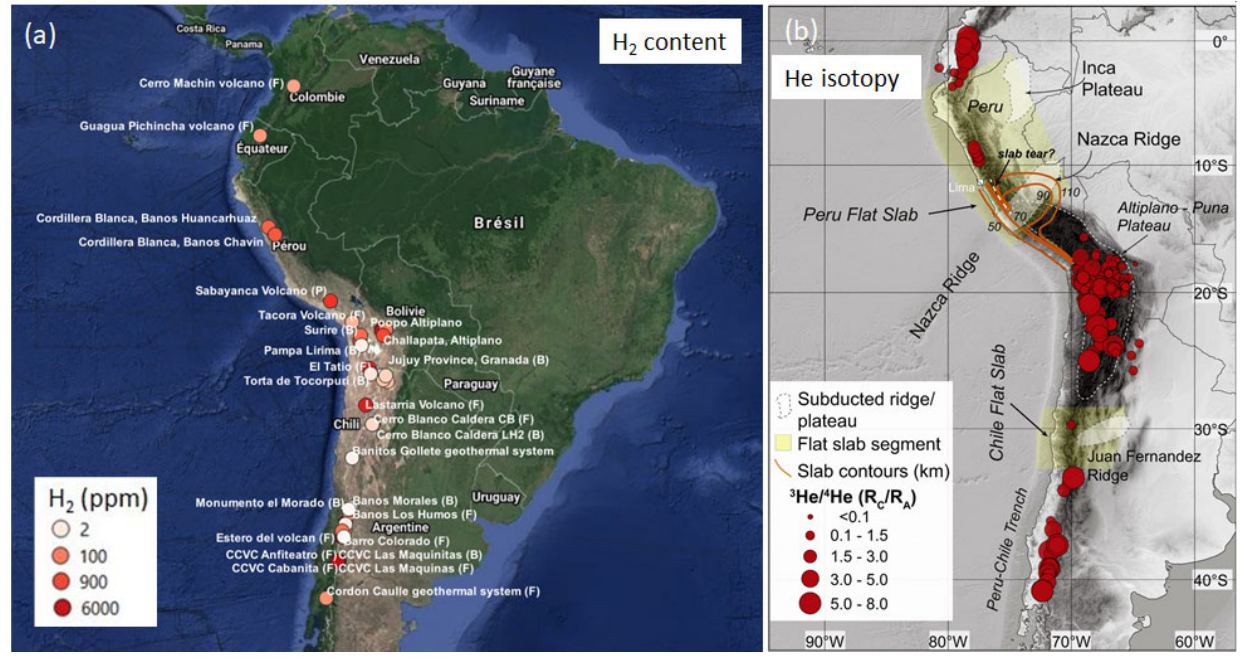
Figure 1. ( a ) Compilation of known H 2 leakages at the scale of the Andes. The highest values reach 5% in Chile. Co—Chanco, F—fumaroles, B—bubbling pool. ( b ) Helium isotopy along the Andes showing the importance of the mantellic gases and the difference between the flat slab area and the dipping slab area (modi fi ed from [17]). The highest values are between 20 and 25° S.